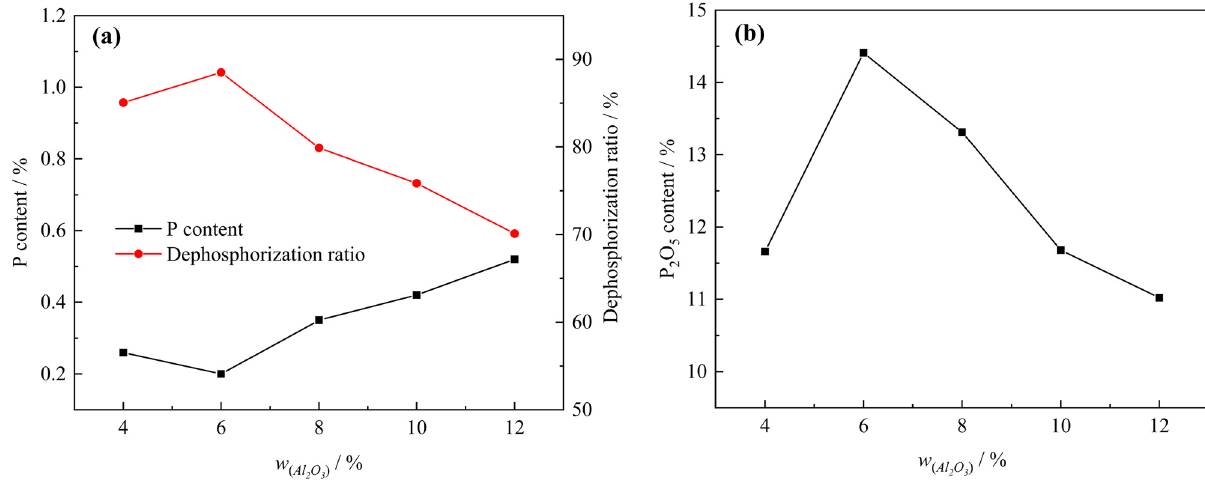
Figure 4: E ff ect of the Al 2 O 3 content on the P content of the fi nal metal and the P 2 O 5 content of the high - P - containing slag: ( a ) P content and dephosphorization ratio and ( b ) P 2 O 5